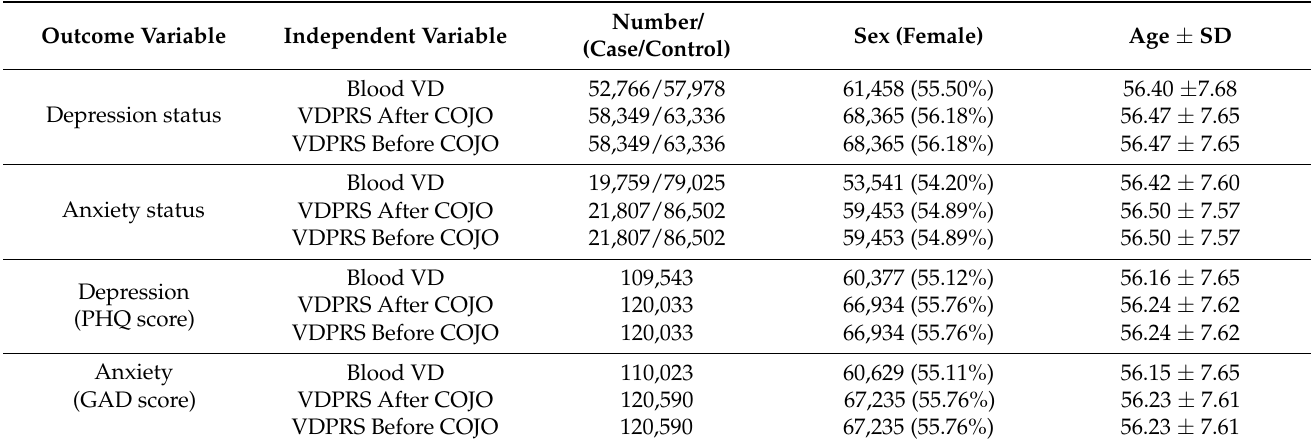
Table 1. General population characteristics of this study participants from UK